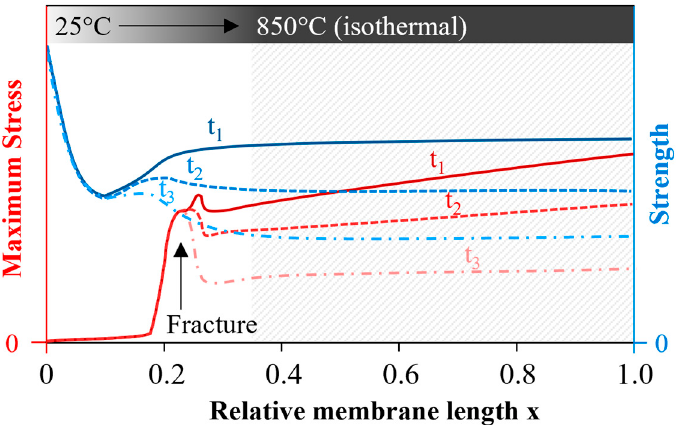
Figure 15. Possible progression of maximum stress and strength for times t 1 < t 2 < t 3 ; fracture occurred at time t 3 since max. stress > strength.